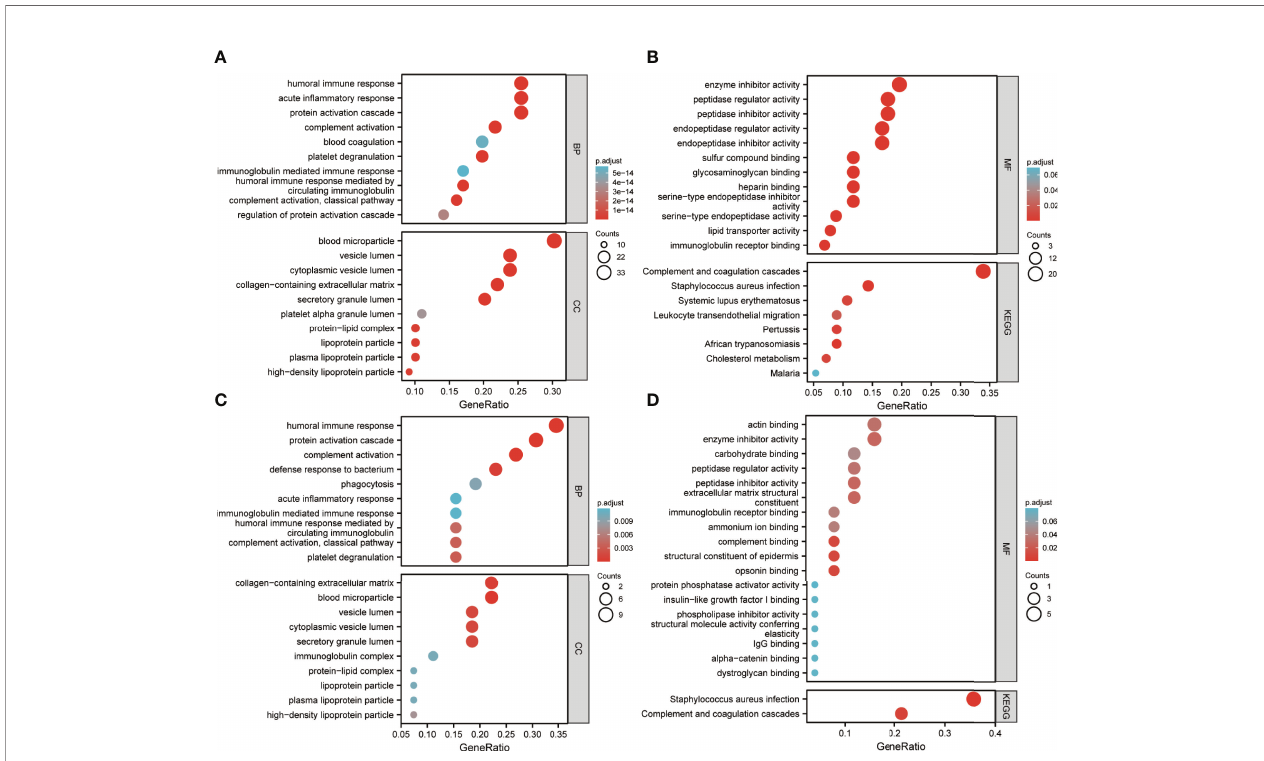
FIGURE 5 | GO and KEGG functional enrichment analyses of pre-EFF vs. post-EFF and post-EFF vs. post-NEFF DEPs. The ordinates in (A − D) represent enriched GO functional classi fi cation terms, including biological process (BP), cellular component (CC) and molecular function (MF) categories, and KEGG pathway. The abscissa represents terms enriched for DEPs under each functional classi fi cation. The size of the bubble represents the number of DEPs, and its colour indicates the signi fi cance of the enriched terms based on Fisher ’ s accuracy. The p -value was calculated by Fisher ’ s Exact test, and the colour gradient represents the size of the p -value from cyan (large) to red (small). (A, B) Functional enrichment analysis results for DEPs between pre-EFF and post-EFF groups. (C, D) Functional enrichment analysis results for DEPs between post-EFF and post-NEFF